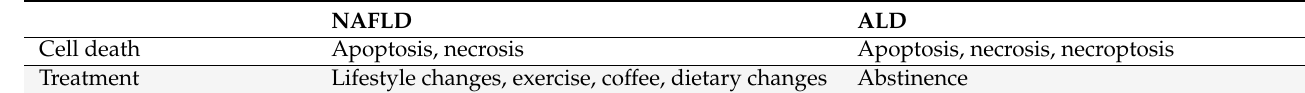
Table 1. Cont . NAFLD ALD